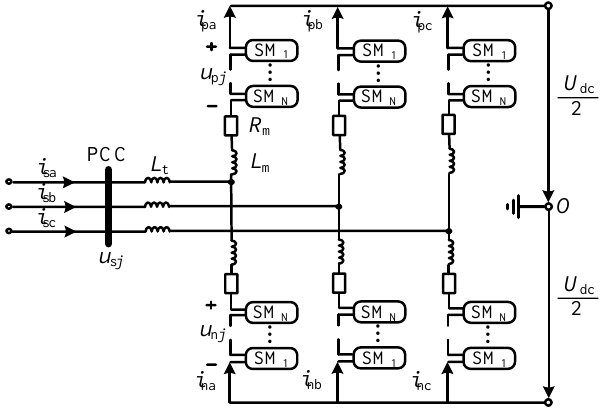
Figure 1. The structure of an MMC-HVDC.